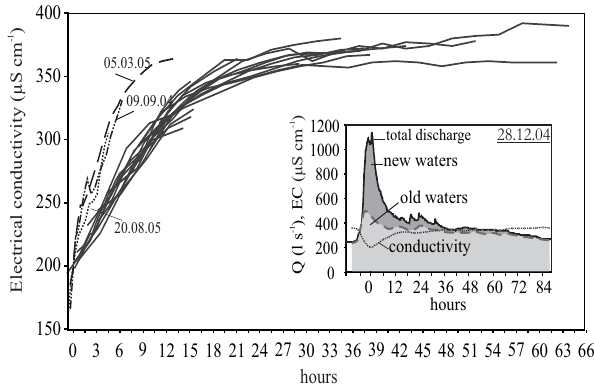
Fig. 9. Hourly evolution of electrical conductivity (µScm − 1 ) in river waters after minimum electrical conductivity of 28 runoff events registered in Aixola catchment. t = 0h corresponds to 200µScm − 1 electrical conductivity. An example of hydrograph separation using conductivity is